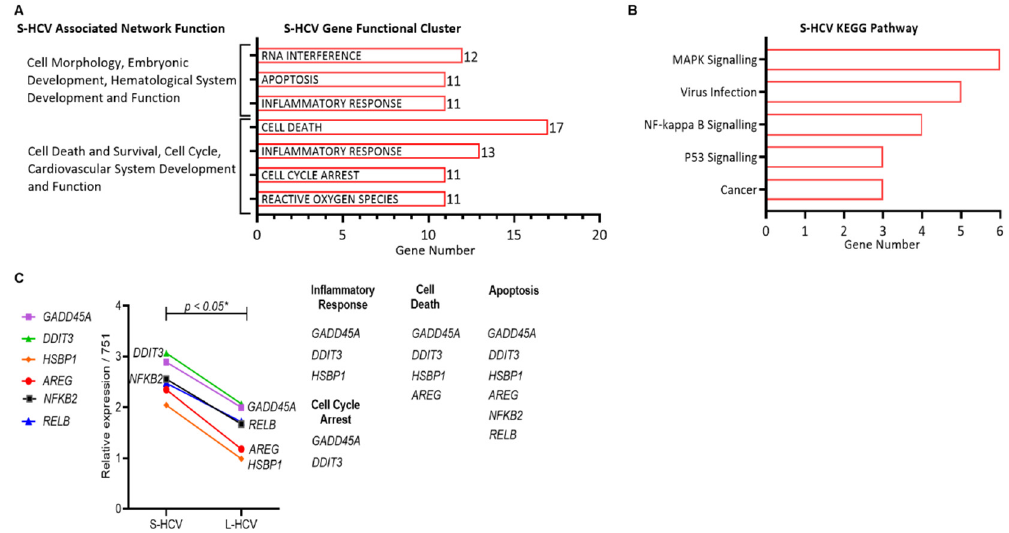
Figure 2. Short-term HCV (S-HCV)-associated network function gene analysis. ( A ) Short-term HCV (S-HCV)-associated network functions and GenClip gene functional clusters ( p < 0.05). ( B ) ShinyGO Kyoto Encyclopedia of Genes and Genomes (KEGG) analysis of the top 6 enriched pathways ( p -value cutoff (FDR) = 0.05) ranked by number of genes from highest to lowest. ( C ) Expression of five genes ( GADD45A , DDIT3 , HSBP1 , AREG , NFKB2 ) in the mitogen-activated protein kinase (MAPK) signaling pathway compared between S-HCV and L-HCV, statistical significance p < 0.05 *. MAPK signaling genes grouped by the functional clusters.